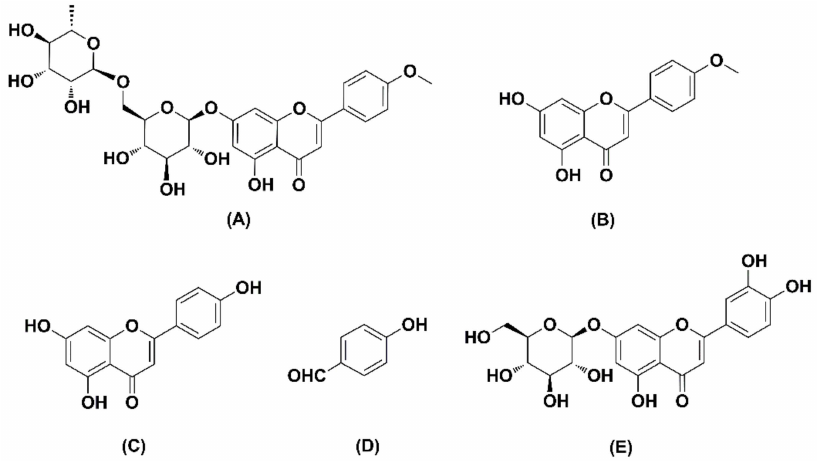
Figure1. Structuresoflinarin( A ),acacetin( B ),apigenin( C ), p -hydroxybenzaldehyde( D ),andluteolin-7- O -glucopyranoside ( E